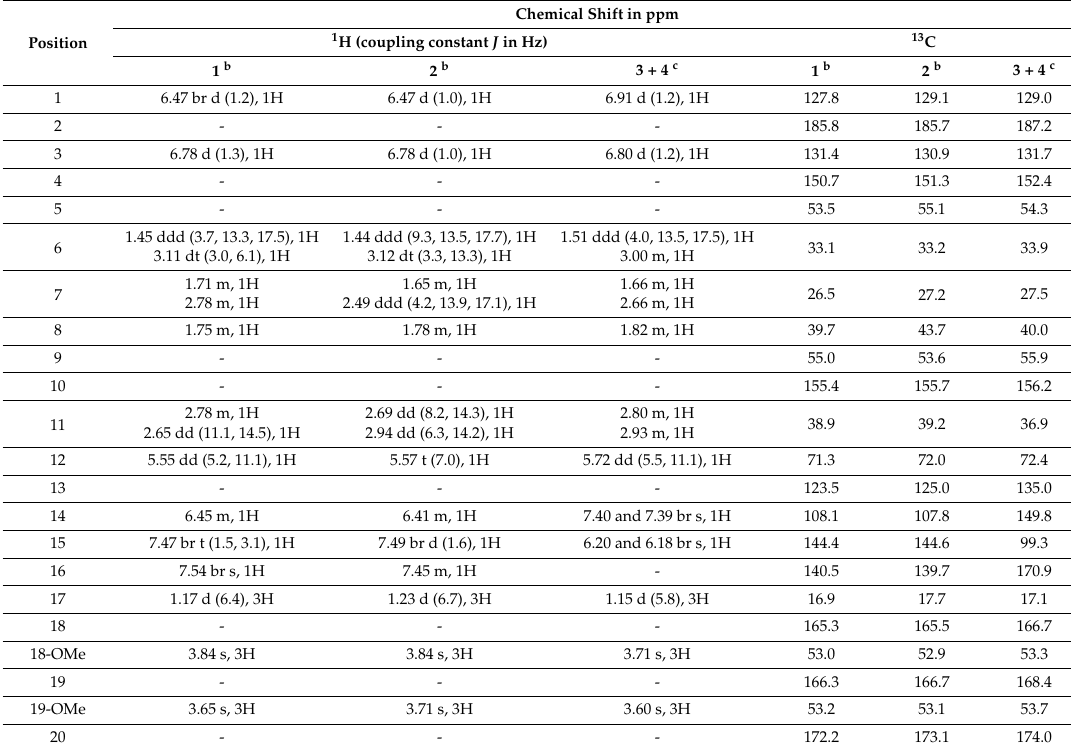
Table 2. 1 H and 13 C NMR data a of diterpenes 1 – 4